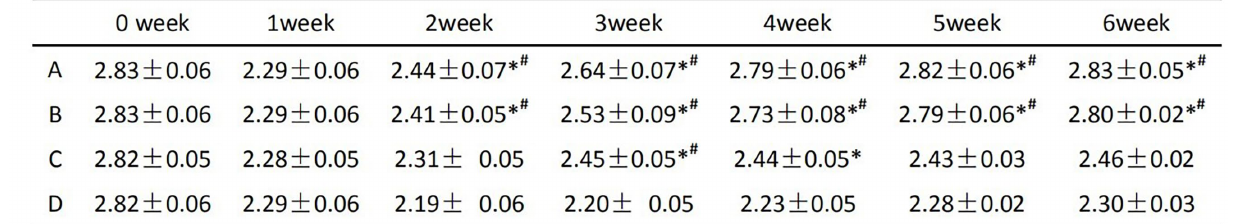
FIGURE 2 | Data on body temperature and weight of the experimental animals. (A) Daily changes in body temperature in each group; (B) weekly changes in body weight in each group; and (C) the average and SD of body weight in each group, in which A, B, C, and D represent the PACT + GM group, PACT group, GM group, and control group, respectively; p < 0.05 indicates a statistically significant; *compared with the control group, # compared with the antibiotic (GM) group. GM, gentamicin.